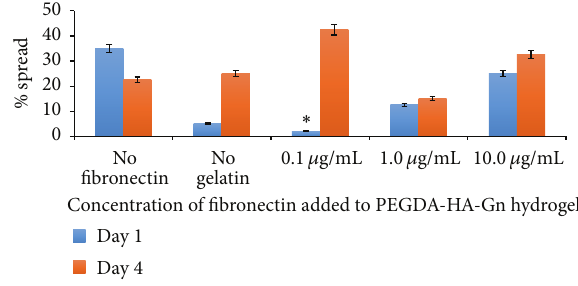
Figure 7: Effect of fibronectin concentration on hDPSC spreading. Data represents an average of 40 cells/field of view at 20x magnifi- cation. 𝑛 = 3 samples. ∗ 𝑝 < 0.05